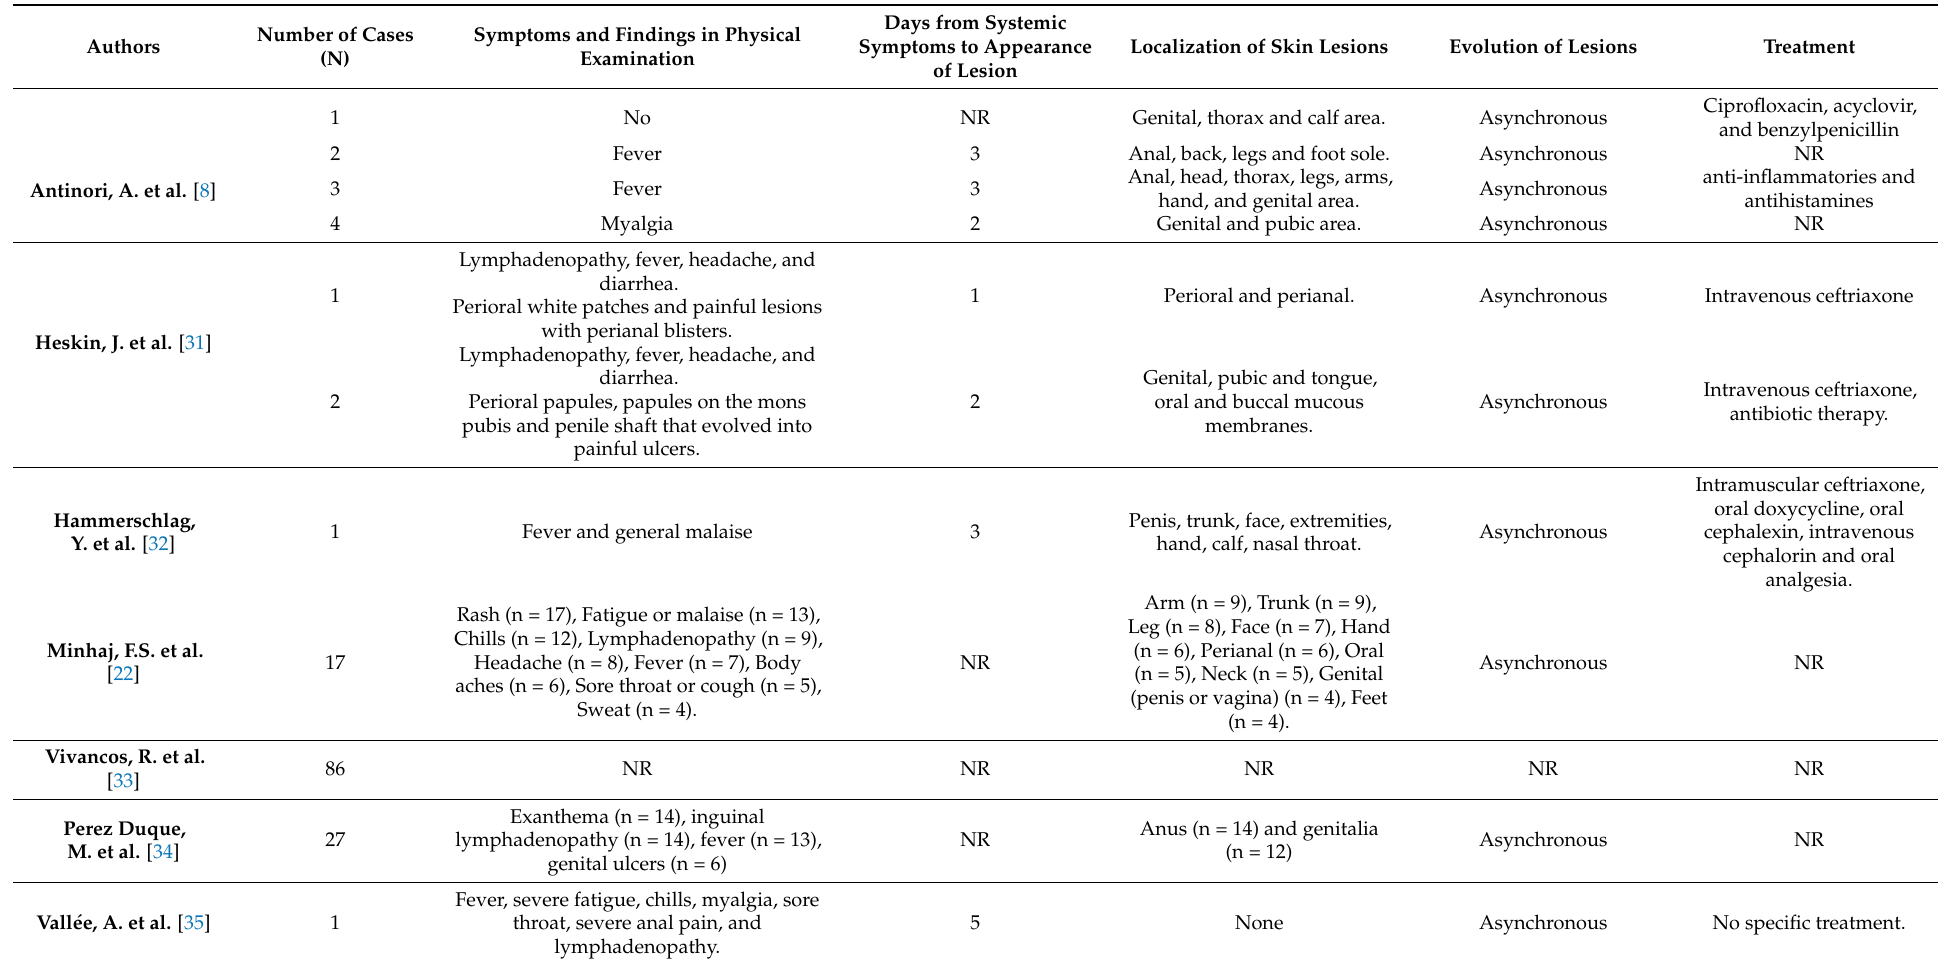
Table 3. Characteristics of eligible studies. Clinical manifestations, localization, the evolution of lesions, and treatment of monkeypox